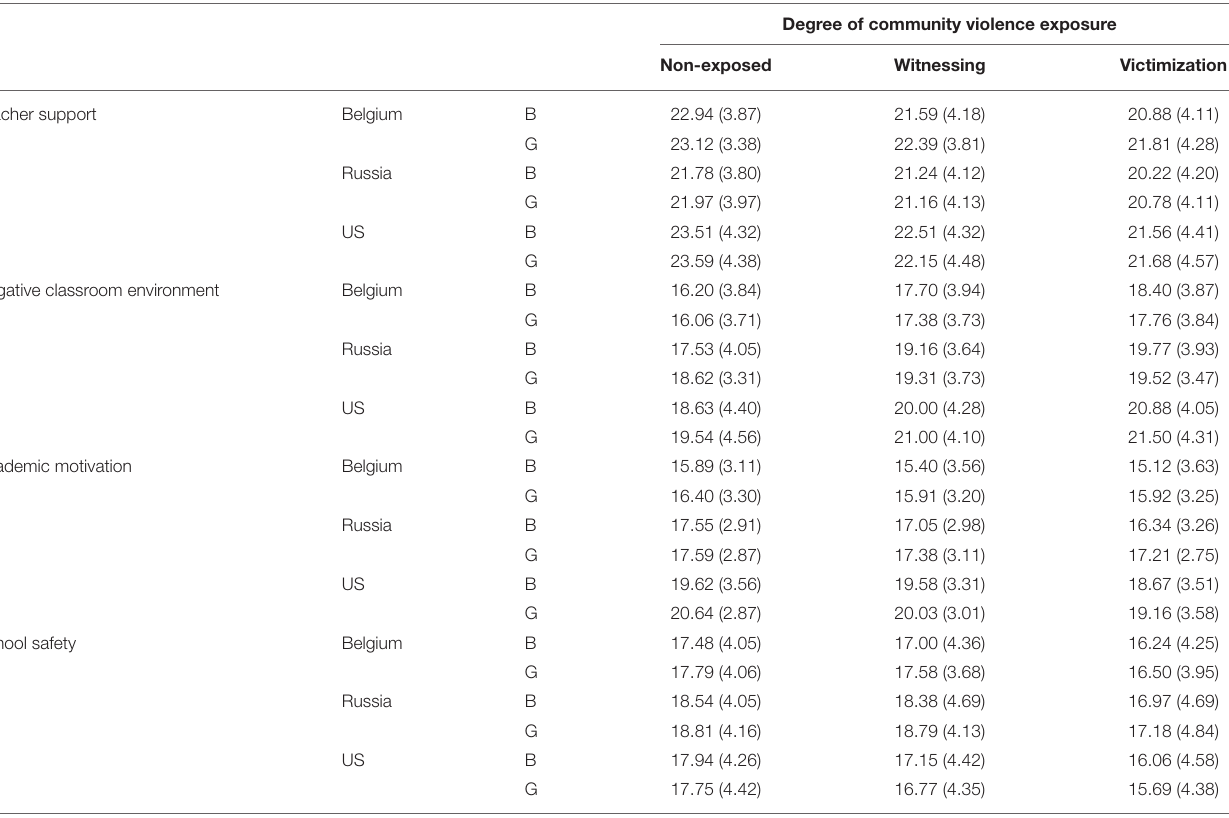
TABLE 2 | Descriptive statistics of the school environment and academic motivation [M (SD)] in Belgium, Russia, and the US by degree of community violence exposure in boys (B) and girls